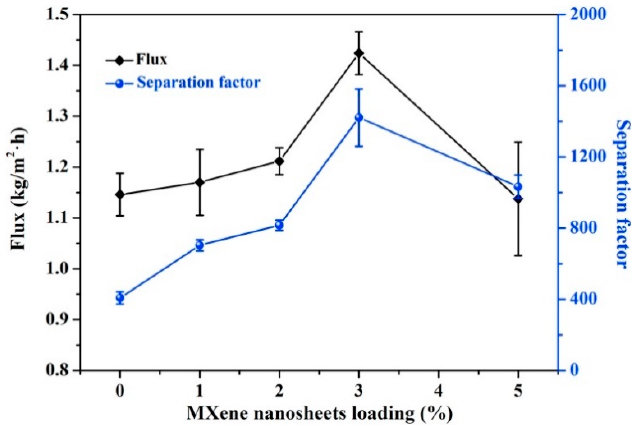
Figure 19. MXene loading effect on the pervaporation performance of MXene/CS MMMs for dehy- dration of 90 wt% water/ethanol mixtures at 50 °C.